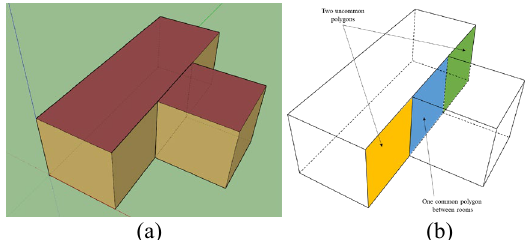
Figure 10. Scenario 3 result. (a) SketchUp visualization; (b)